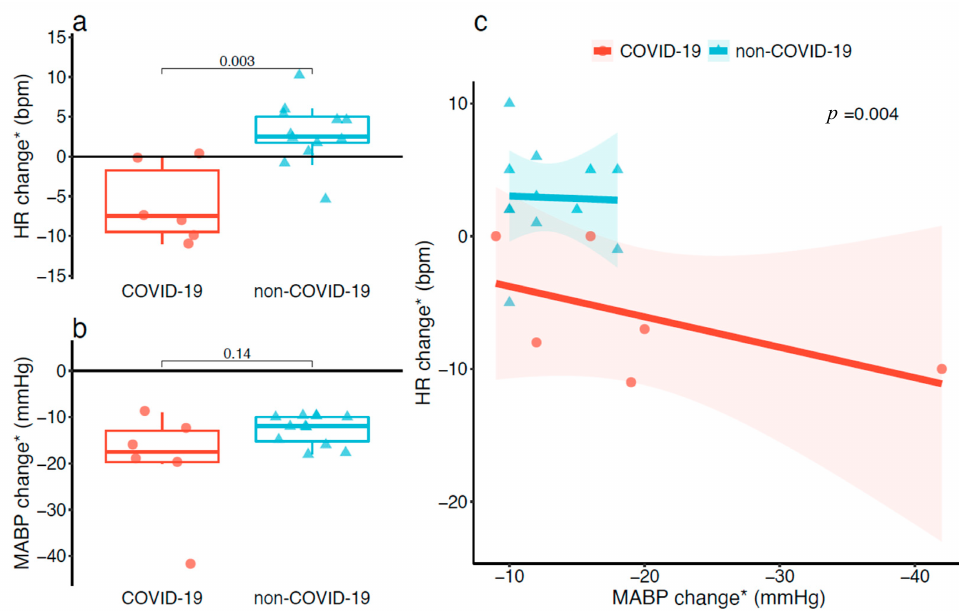
Figure 2. Changes in the heart rate ( a ) and mean arterial blood pressure ( b ) during CVVHDF- induced hypotension, contrasting COVID-19 patients and non-COVID-19 patients. Linear regression ( c ) showing a non-physiological association between mean arterial blood pressure change and heart rate change. Abbreviations: COVID-19, coronavirus infectious disease 2019; CVVHDF, continuous venovenous hemodiafiltration; HR, heart rate; MABP, mean arterial blood pressure. * Parameters at the time of CVVHDF-induced hypotension onset minus parameters at the time of last hemodynamic monitoring before CVVHDF-induced hypotension (maximum of two hours before).